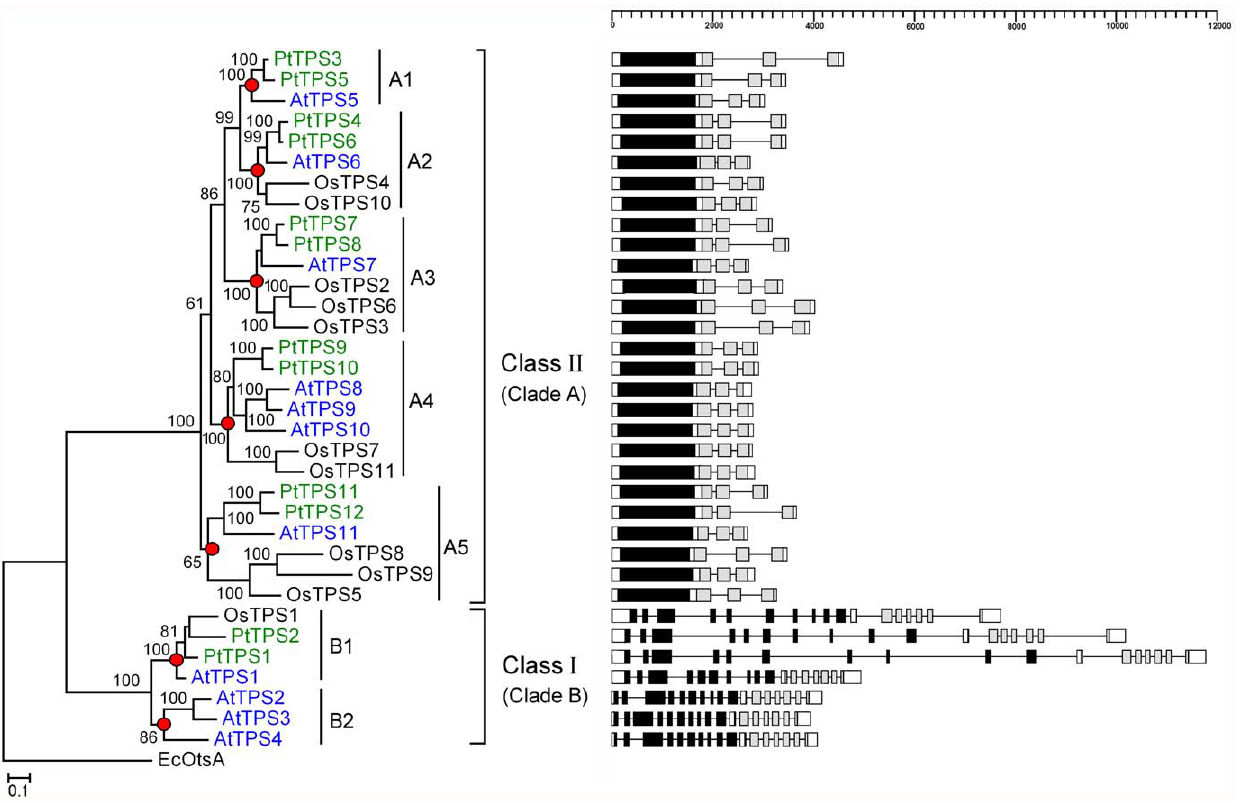
Figure 1. Phylogenetic relationships (A) and gene structures (B) of the TPS genes from Populus , Arabidopsis, and rice. Red circles indicate the most recent common ancestral TPS genes among Populus , Arabidopsis, and rice. Only bootstrap values . 50% are shown. The TPS and TPP domains are highlighted by the black and grey boxes, respectively.